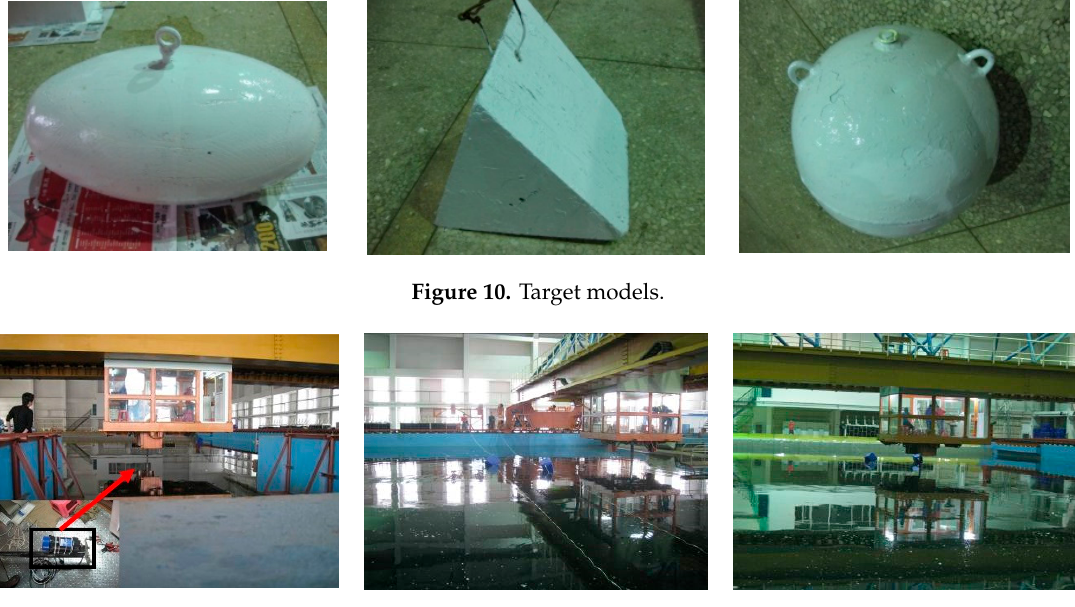
Figure 11. Experiment environment.